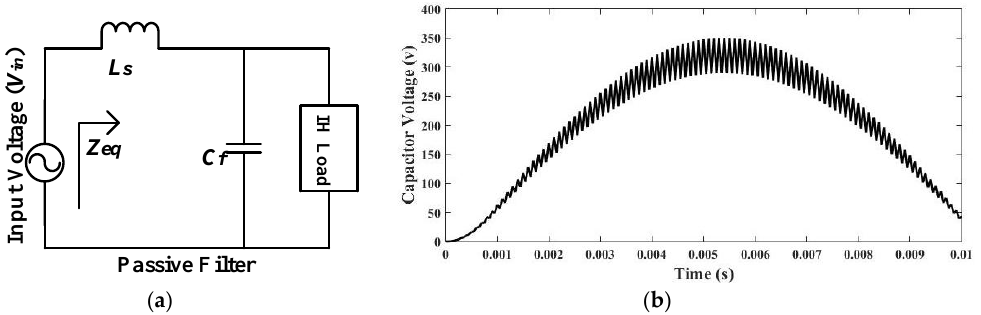
Figure 12. ( a ) Passive filter and ( b ) voltage across capacitive filter.